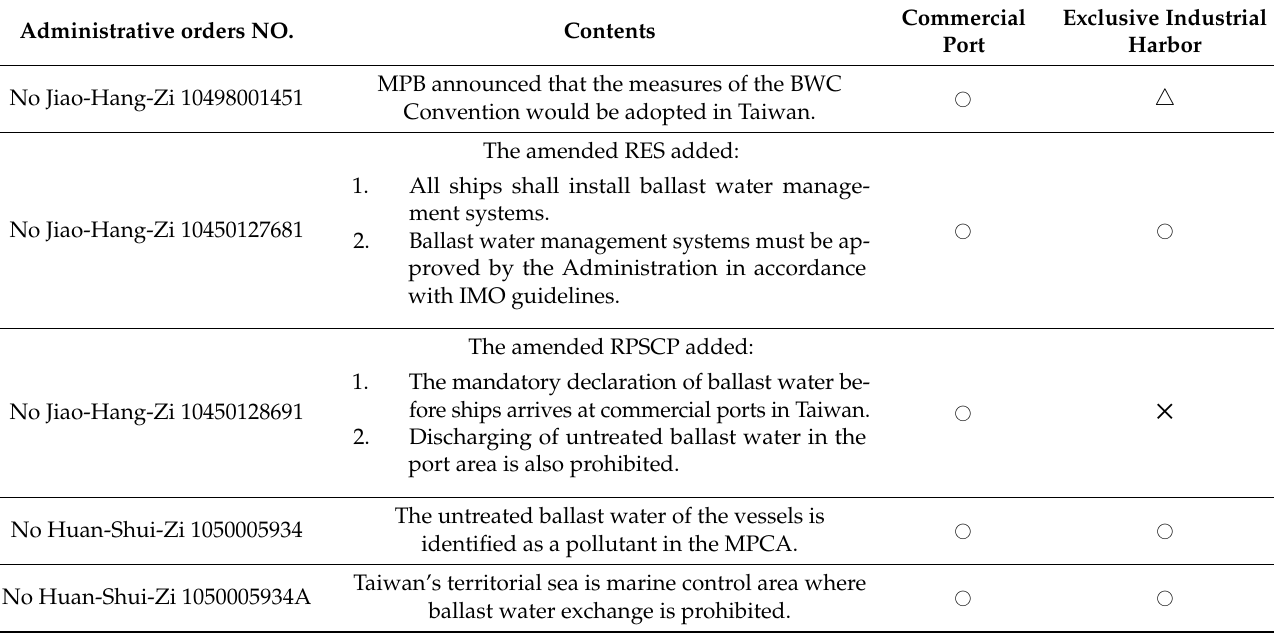
Table 6. Taiwan ballast water authority and